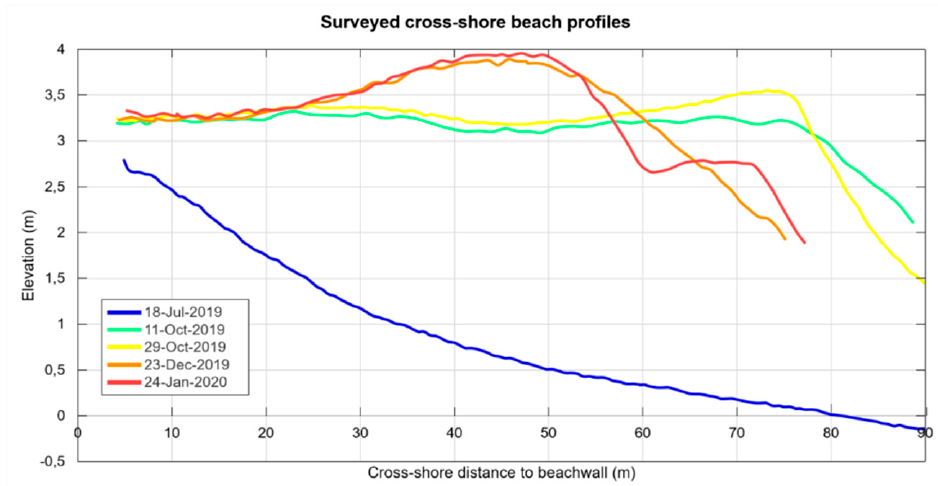
Figure 5. Surveyed cross-shore beach profiles of the Tarquínio-Paraíso beach. The elevation of each profile is referred to mean sea level (MSL).